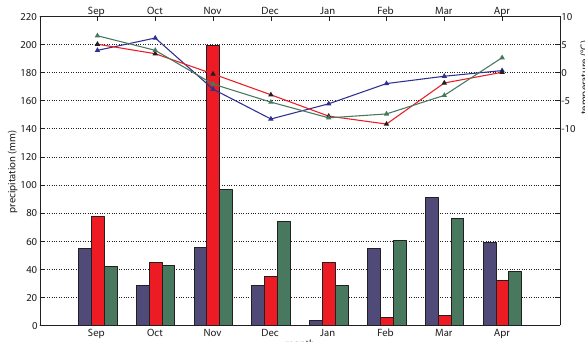
Fig. 3. Monthly precipitation sums (bars) and monthly mean tem- perature (lines) at the automatic weather station in Vent for the analyzed accumulation seasons 2002 (blue), 2003 (red) and 2009